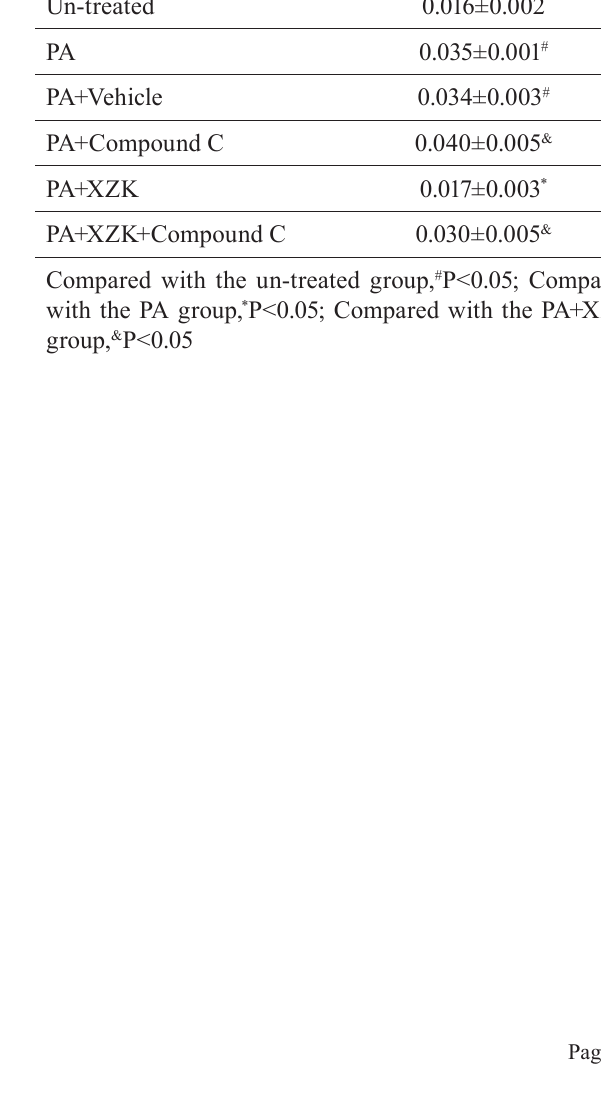
TABLE II - TG content of intracellular HepG2 cells after 24 TABLE III - Intracellular TG content of HepG2 cells by pre- h intervention with XZK (n=4, ±s) treatment of Compound C (n=4, ±s) Group TG Content (umol/mg.prot) TG Concentration Group (umol/mg.prot) Un-treated 0.017±0.002 Un-treated 0.016±0.002 PA 0.036±0.003 # PA 0.035±0.001 # PA+Vehicle 0.036±0.004 # PA+Vehicle 0.034±0.003 # PA+250μg/ml XZK 0.020±0.001 * Compared with the un-treated group, # P<0.05; Compared 0.030±0.005 & with the PA group,*P<0.05 Compared with the un-treated group, # P<0.05; Compared with the PA group, * P<0.05; Compared with the PA+XZK group, &